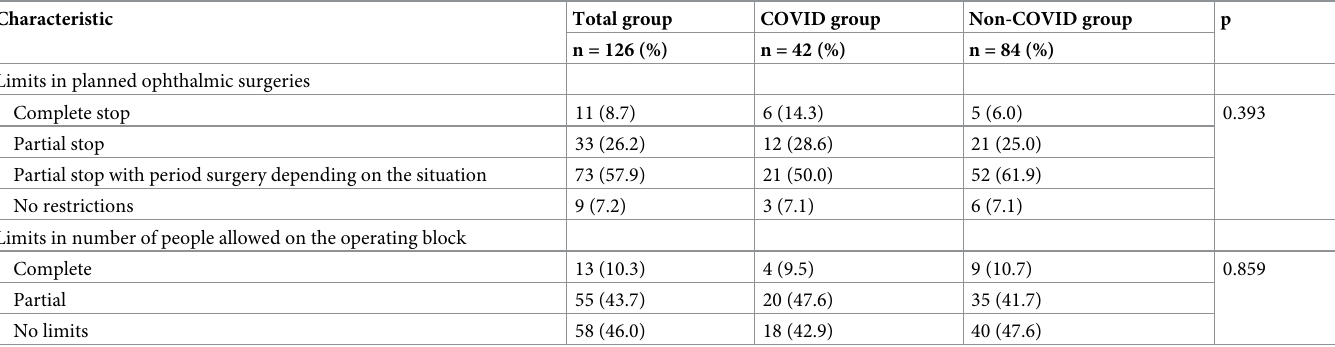
Table 2. Limitations in the operating theater during the COVID-19 pandemic as assessed by residents working and not working with patients with COVID-19. Characteristic